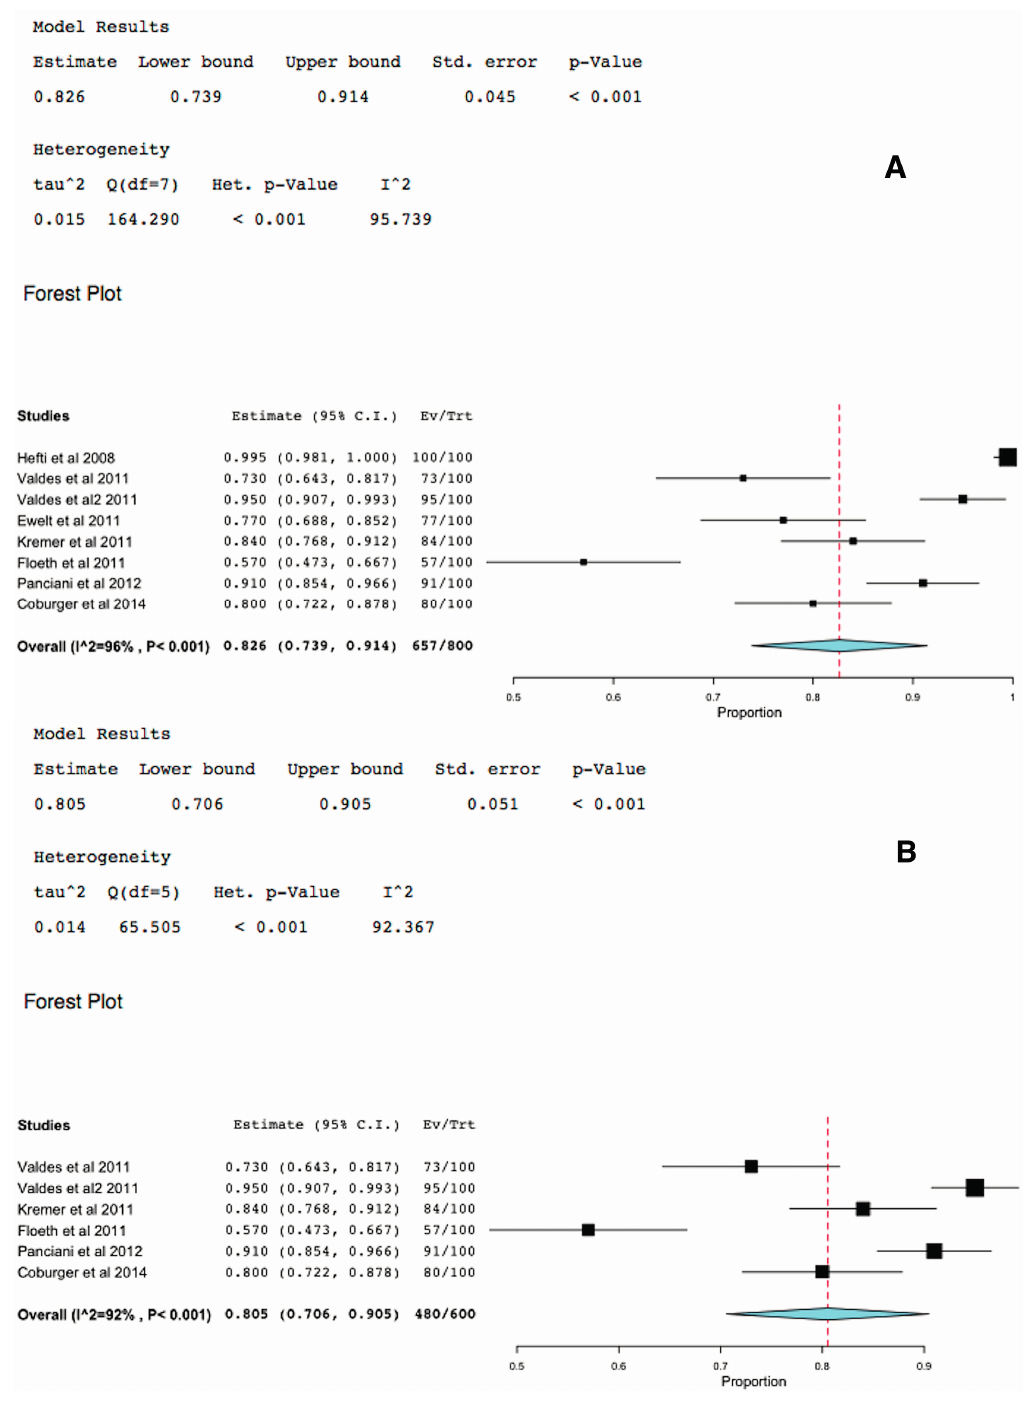
Figure 6. Forest plot (meta-analysis) and heterogeneity of 5-ALA-FIGR sensitivity. ( A ) excludes studies with non-GBM data and ( B ) includes them, because studies [19,22] included other types of tumors other than GBM. (Squares represent the mean, the bigger the square is the more weight given because of the narrower 95% CI, the diamond represent the mean in the combined data in the meta -